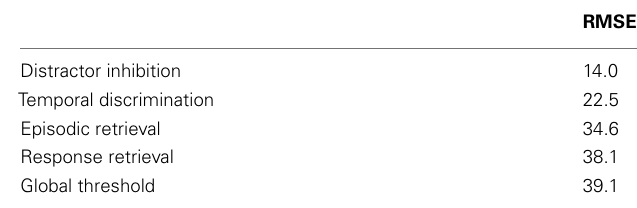
descent fit to the absolute reaction time of a control trial (COs and COr) and the priming effects of DTs, DTr, andTTs andTTr while keeping the theory weights fixed.